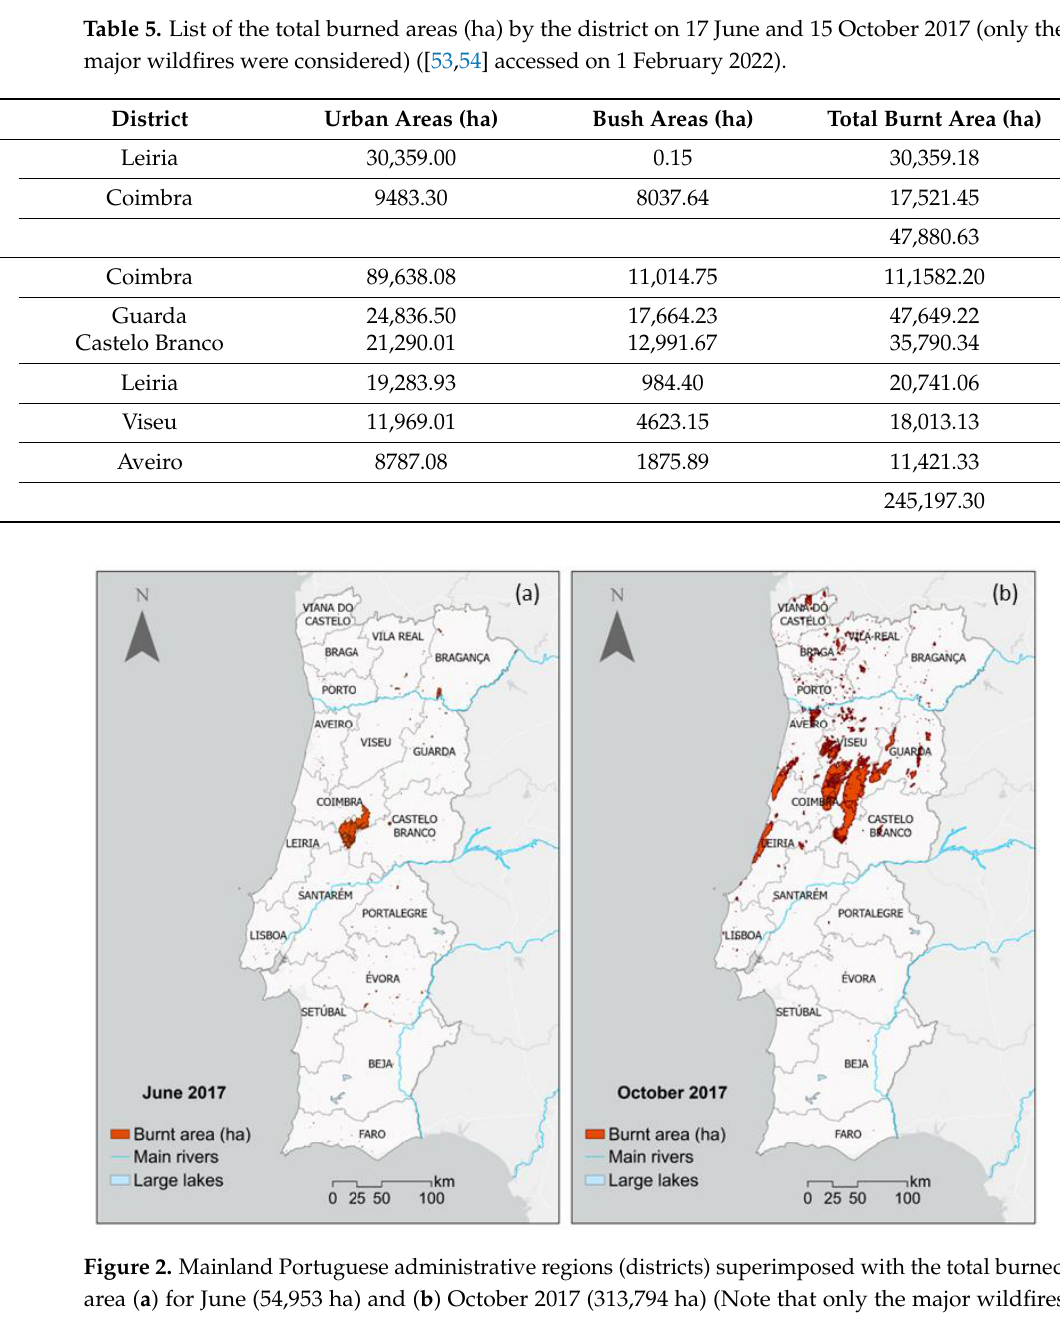
Figure 2. Mainland Portuguese administrative regions (districts) superimposed with the total area ( a ) for June (54,953 ha) and ( b ) October 2017 (313,794 ha) (Note that only the major burned area ( a ) for June (54 953. ha) and ( b ) October 2017 (313 794. ha) (Note that only the major wildfires were considered; and, the burned area polygons were attained from ICNF, the Portuguese rural fire database ([43,53–55], accessed on 31 November 2021)).